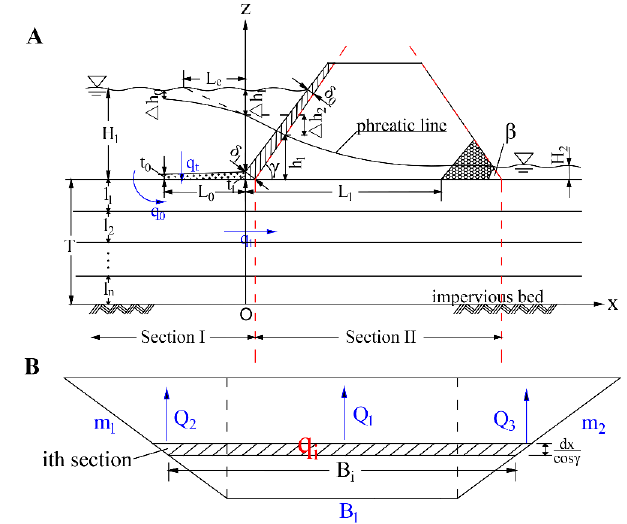
Figure 2. Layout generalization of the slope-wall dam with a horizontal blanket (high groundwater level): ( a ) a typical cross section of the dam; ( b ) front view of the simplified slope wall.